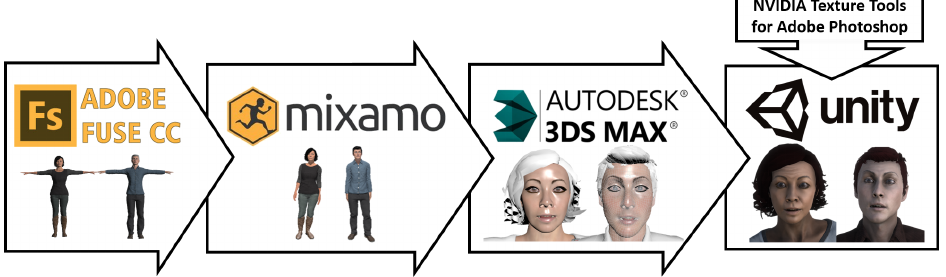
Figure 1. Workflow of the dynamic virtual humans’